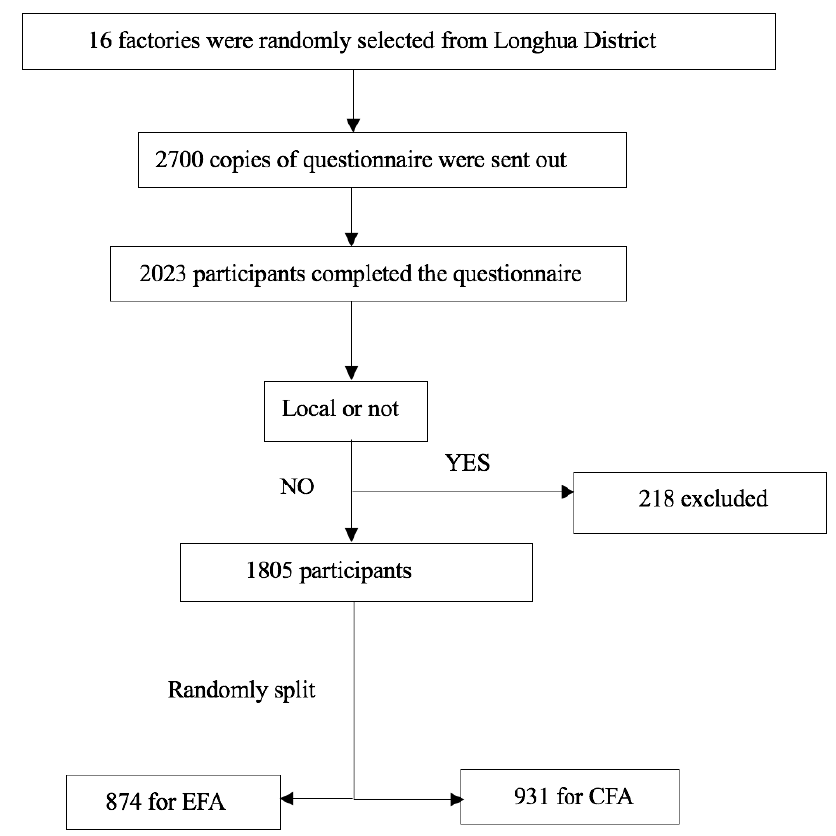
Figure 1. Participants recruitment flow chart. Table 1. Sociodemographic characteristics of industrial workers. ( n =